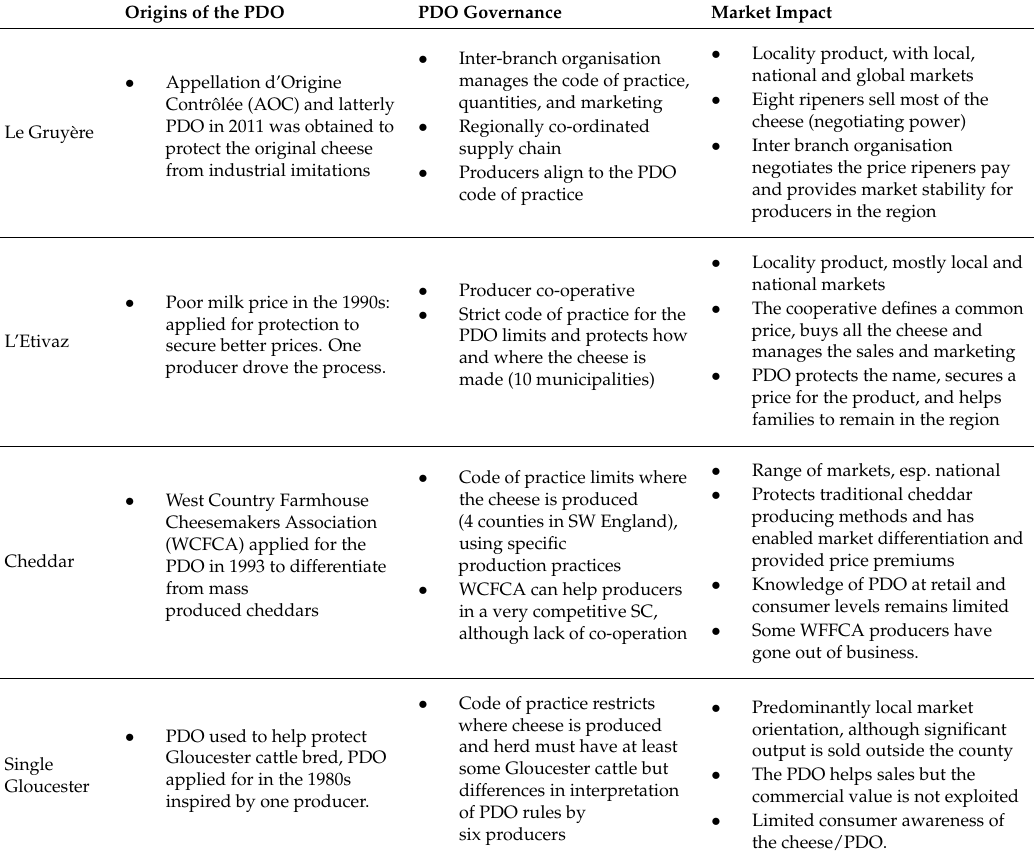
Table 2. Swiss and UK PDO case study cheeses: key comparative